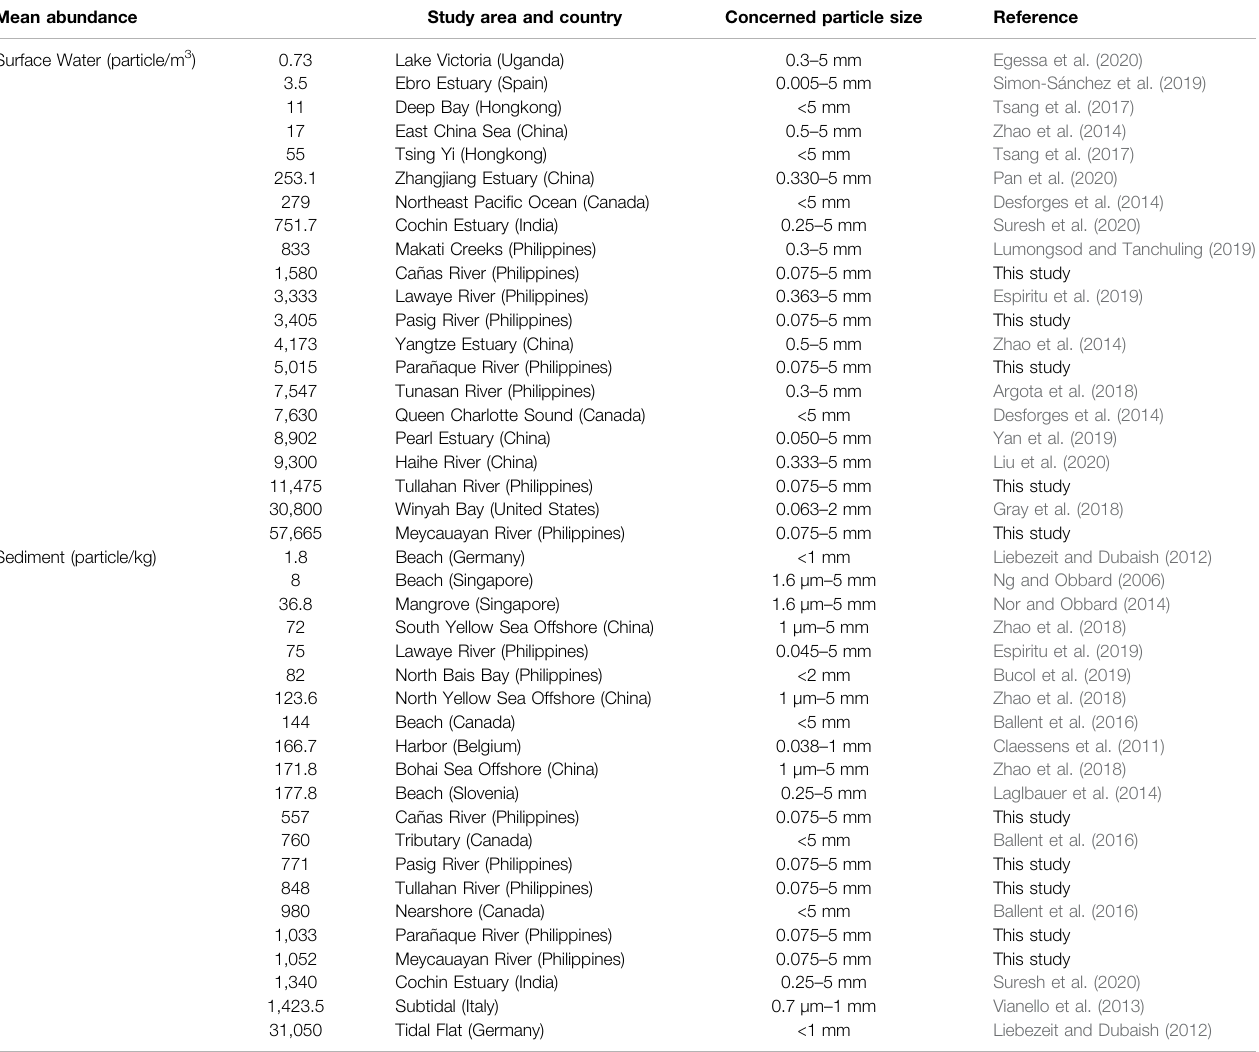
TABLE 3 | Mean abundance of microplastics reported in surface water and